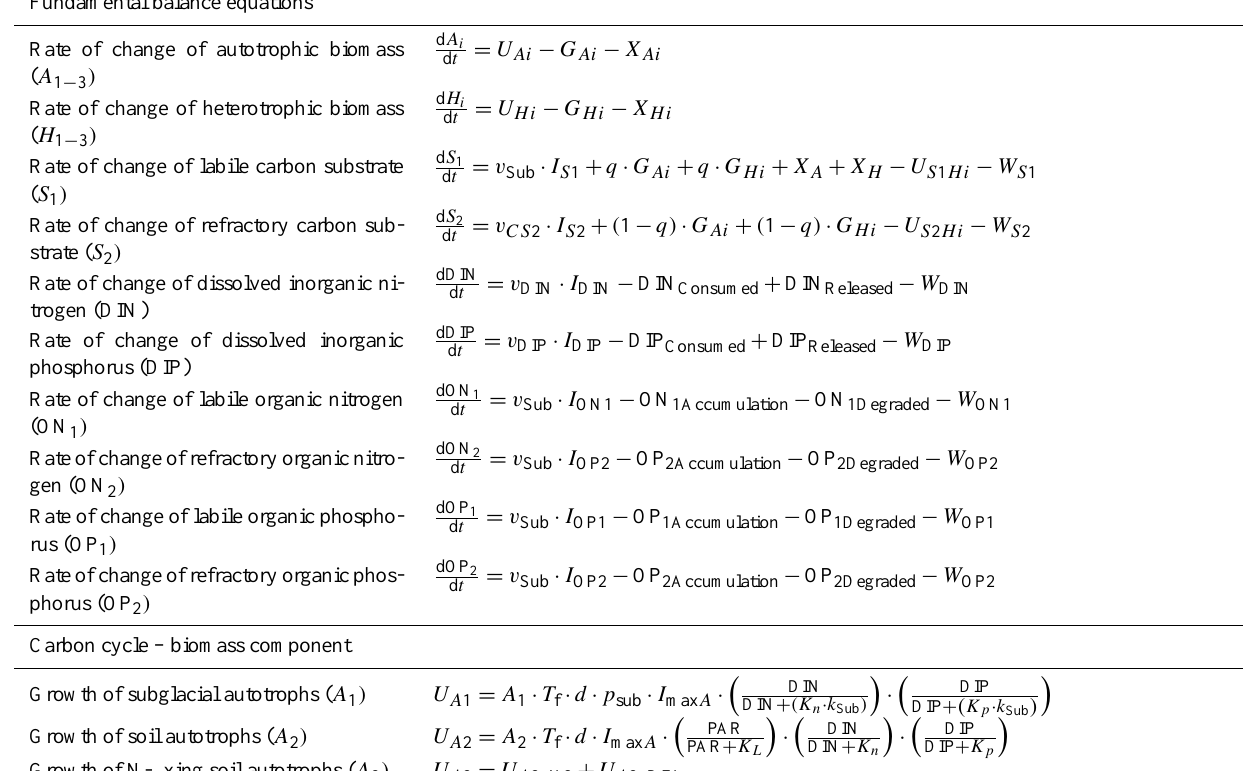
Table 4. SHIMMER model